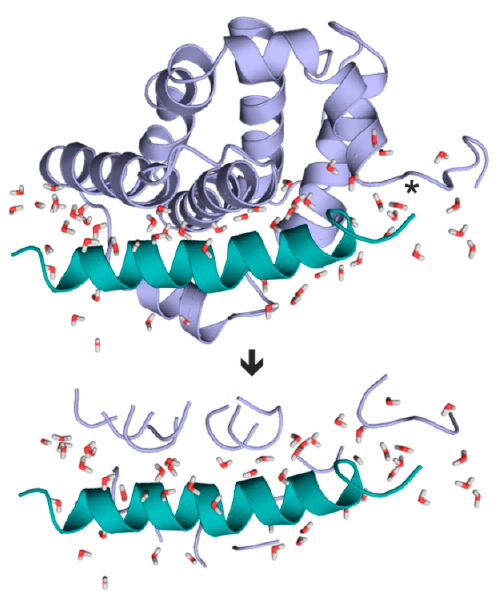
Figure 1. Fragmenter extracts a hydrated interface (bottom) from the target-ligand complex (top). Target (fragments) and ligand are shown in light blue, and green, respectively. System 2roc contains the largest ligand investigated in the present study. In this example, Fragmenter extracted target residues with (d TL = 5.0 Å) considerably reducing the system size used for QM calculation. Interfacial water molecules (d W = 5.0 Å, sticks) are also retained. Steps of extraction of target fragments are shown in atomic details for the C-terminal region (asterisk) in Figure S3 as an example. Fragmenter is available free of charge as a web service at